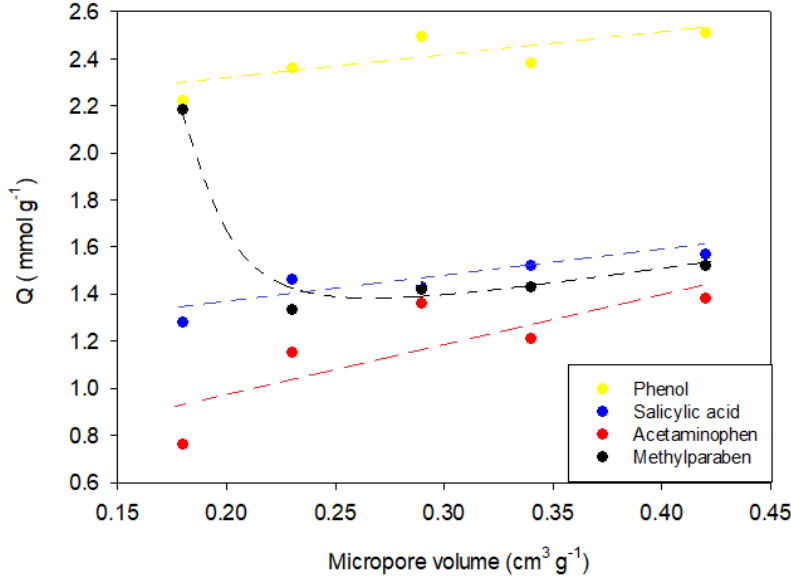
Figure 8. Relation between the adsorption capacity of phenol, acetaminophen, salicylic acid, and methylparaben and the micropore volume of activated carbons CAO, CAG, CAR1073, CAR1173, and CAR1273. Dashed lines represent a tendency of data.